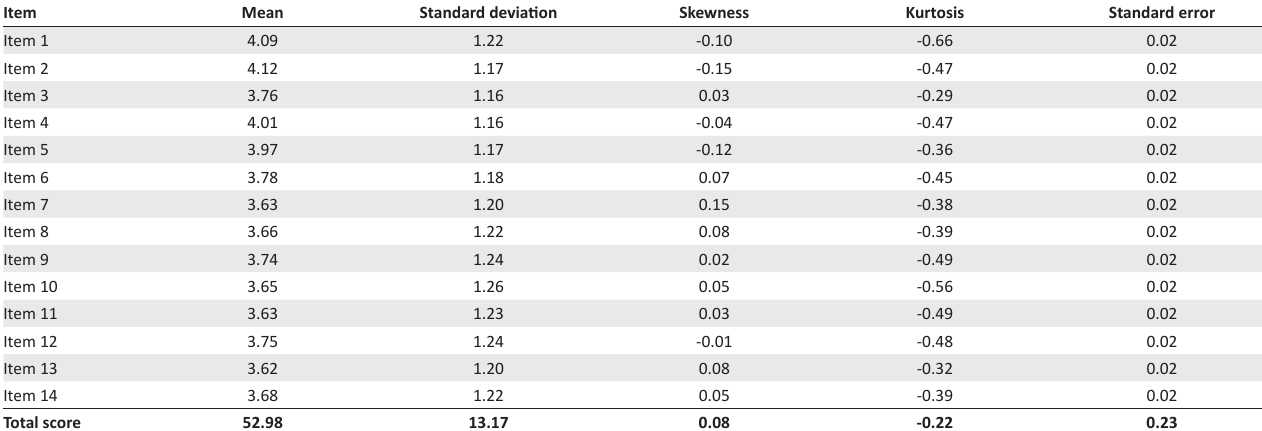
TABLE 1: Descriptive